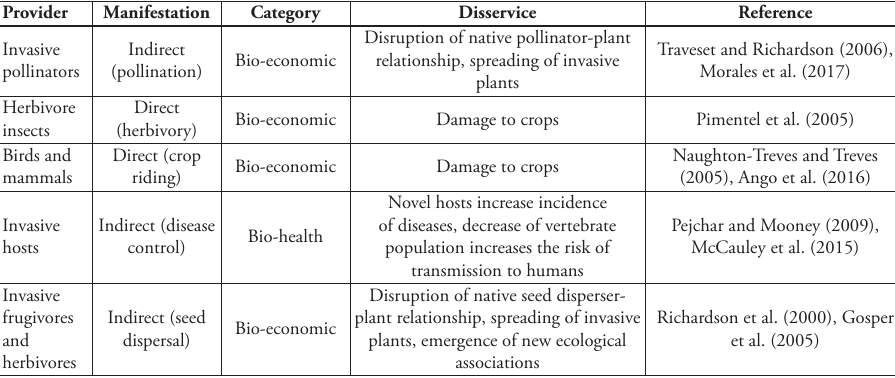
Table 2. Faunal ecosystem disservices. Selected examples of disservices related to agriculturalisation caused by fauna, describing providers, type of manifestation: direct or indirect (when causes decrease or loss of a service), category (according to Shackleton et al. 2016) and impact on human well-being. Provider Manifestation Category Disservice Reference Traveset and Richardson (2006), Morales et al. (2017) plants Pimentel et al.